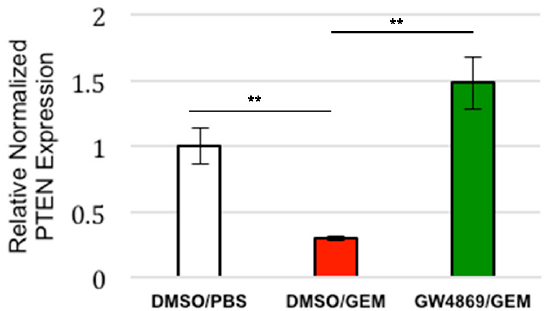
Figure 3. Evaluation of the effect of GEM treatment and exosome inhibition on PTEN expression in in vivo PDAC model. Mice with subcutaneous tumors (PDACs+CAFs) were treated for two weeks with PBS, Gemcitabine, or GW4869/Gemcitabine, and their PTEN mRNA levels were quantified via RT-PCR. ** p < 0.01.